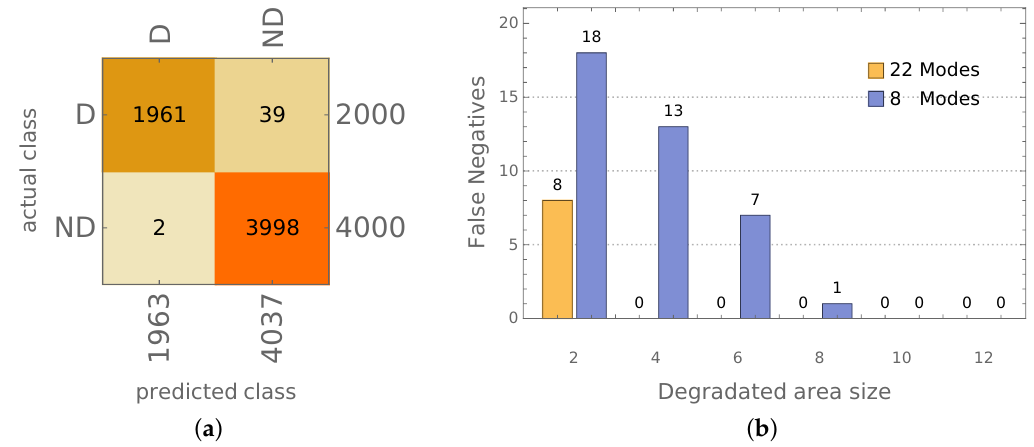
Figure 15. ( a ) The results of PA model identification (testing, 8 mode shapes involved), ( b ) false negatives for different sizes of area with material constants